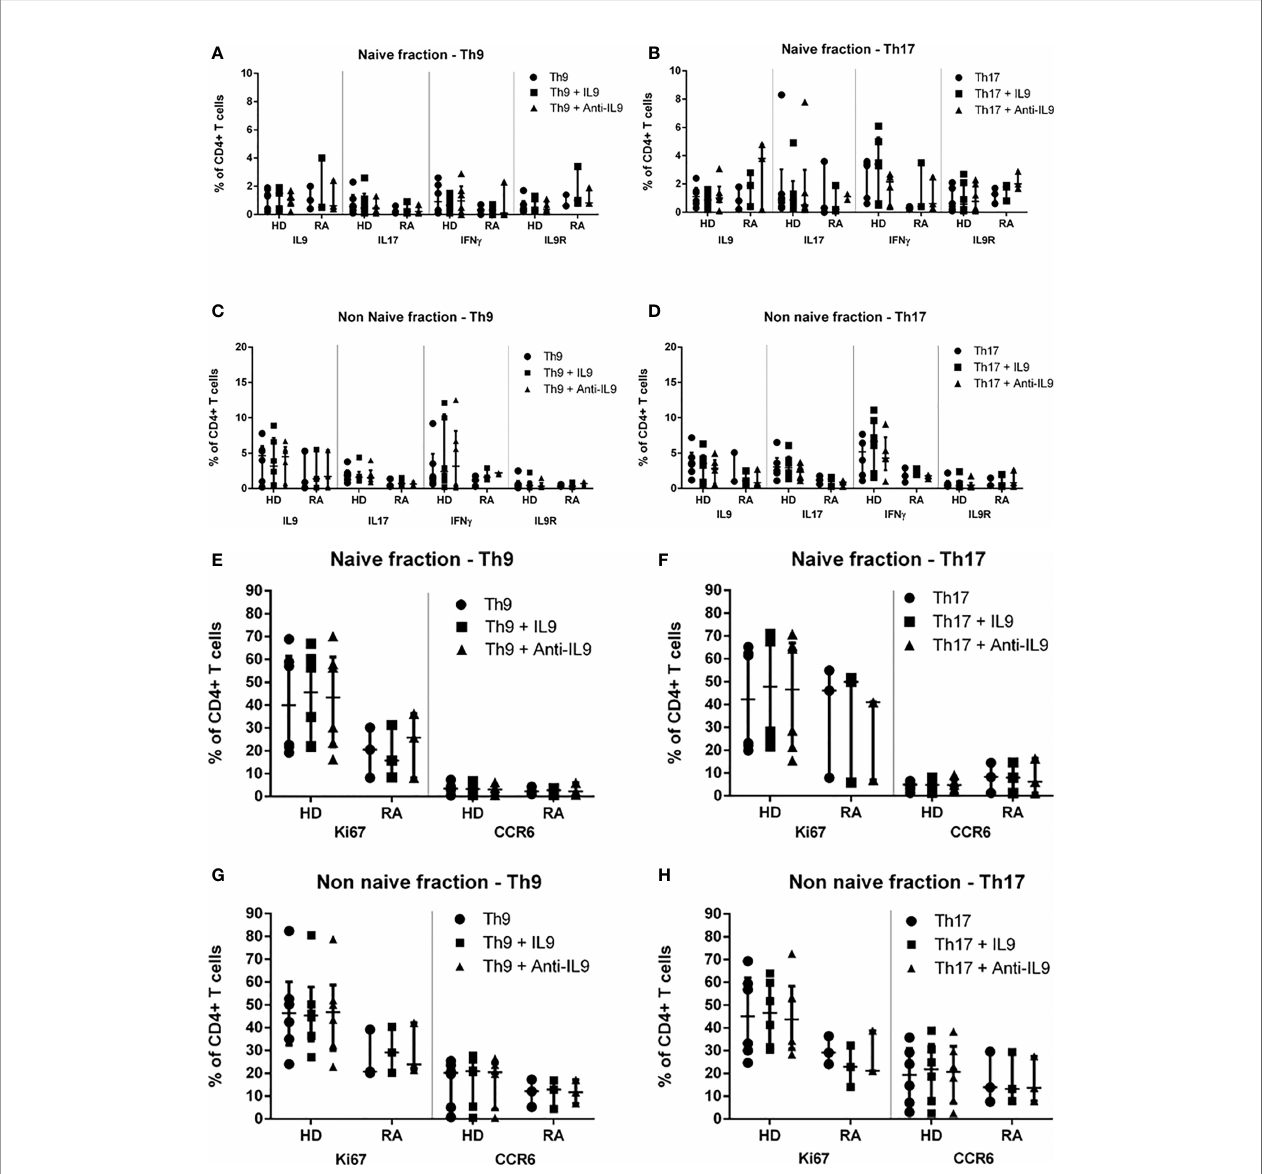
FIGURE 3 | Proportions of IL-9-, IL-17-, IFN g -, IL-9R-, Ki67- and CCR6-expression in naive and non-naive CD4+ T cells in Th9- or Th17-inducing cytokine conditions supplemented with IL-9 or anti-IL-9 in healthy donors (HD) and in rheumatoid arthritis (RA) patients. Percentages of IL-9+, IL-17+, IL-9R+, IFN g +, Ki67+ and CCR6+ cells are shown in the naive of CD4+ peripheral T cells which were investigated after 3d cell culture under Th9- (A, E) or Th17-stimulating (B, F) cytokine conditions modi fi ed by IL-9 excess or anti-IL-9 treatment in lymphocytes derived from patients with rheumatoid arthritis (RA) and healthy donors (HD) by fl ow cytometry. Percentages of IL-9+, IL-17+, IL-9R+, IFN g +, Ki67+ and CCR6+ cells are shown in the non-naive of CD4+ peripheral T cells which were investigated after 3d cell culture under Th9- (C, G) or Th17-stimulating (D, H) cytokine conditions modi fi ed by IL-9 excess or anti-IL-9 treatment in lymphocytes derived from patients with rheumatoid arthritis (RA) and healthy donors (HD) by fl ow